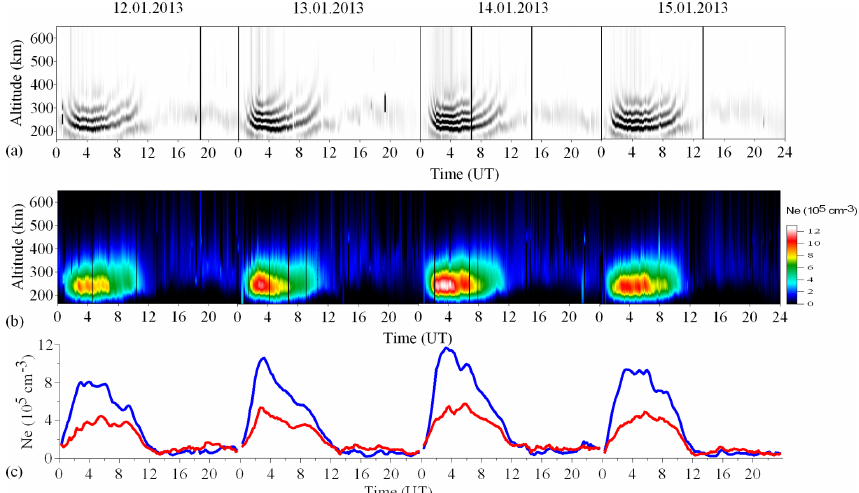
Figure 8. (a) Vertical profiles of IS signal power, measured using the 11-element code sequence with a total duration of 150µs. (b) Vertical electron density profiles from the automated procedure. (c) Time variability of the electron density at 259km (blue line) and 325km (red line).